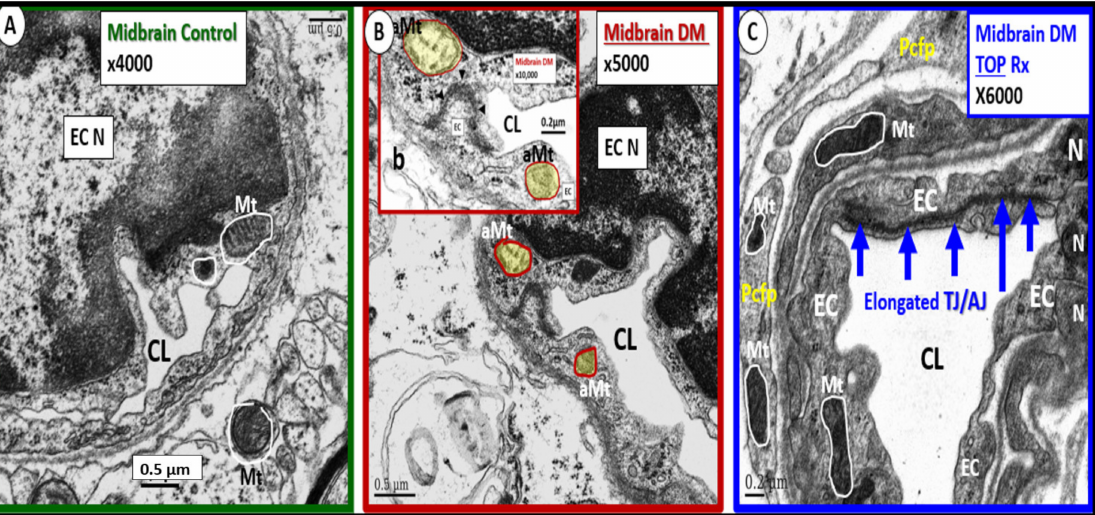
Figure 12. Mitochondria remodeling to an aberrant phenotype (aMt) in the male CD-1 mouse midbrain neurovascular unit brain endothelial cell(s) (EC) with streptozotocin-induced diabetes that was ameliorated with topiramate treatment. Panel A demonstrates the normal electron-dense mitochondria (Mt) in the endothelial cell (EC) cytoplasm (outlined in white lines) in the control model of the neurovascular unit (NVU) in the midbrain. Additionally, note the electron-dense Mt in the adjacent astrocyte of the NVU. Panel B depicts the aberrant mitochondria (aMt) in the EC NVU that are hyperlucent with loss of electron-dense Mt matrix and cristae (pseudo-colored yellow outlined in red). Insert ( b ) depicts this image at higher magnification. Panel C illustrates the electron-dense Mt (outlined in white lines) within the EC cytoplasm and the adjacent pericyte foot process (Pcfp) of the NVU. Additionally, note the elongated tight and adherens junction (TJ/AJ) of the EC (blue arrows) responsible for the blood-brain barrier of the NVU. Further, note that topiramate (TOP) treatment ameliorated the aMt in the diabetic midbrain in panel C. These modified images are from the experiment with permission by CC 4.0 in reference [38]. Magnifications vary and are located on the upper right-hand side and scale bars are located on the bottom left-hand side of each image. CL= capillary lumen; N =